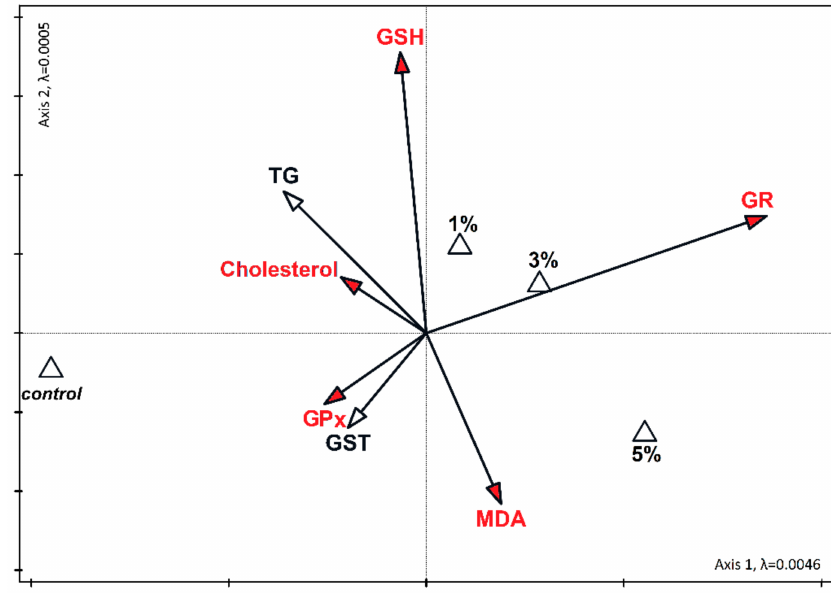
Figure 2. Canonical correspondence analysis (CCA) for the biochemical parameters in the liver of mice fed with different content of Pinnularia borealis (1%, 3%, and 5 %, and 0% for controls). Biochemical parameters are presented with vectors, and different algae concentrations in food are marked with triangles. The vectors of variables significantly differentiating the examined sets are marked in red. The eigenvalues canonical axes are marked in lambda ( λ